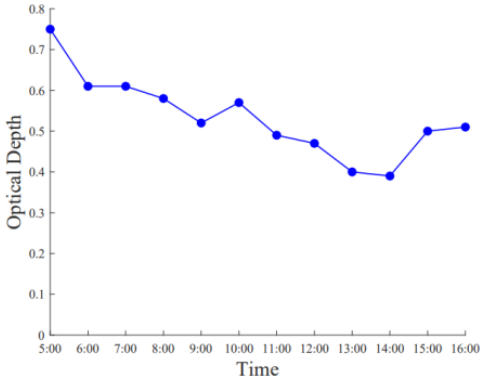
Figure 11. Optical thickness of sea spray from solar radiometer measurements.